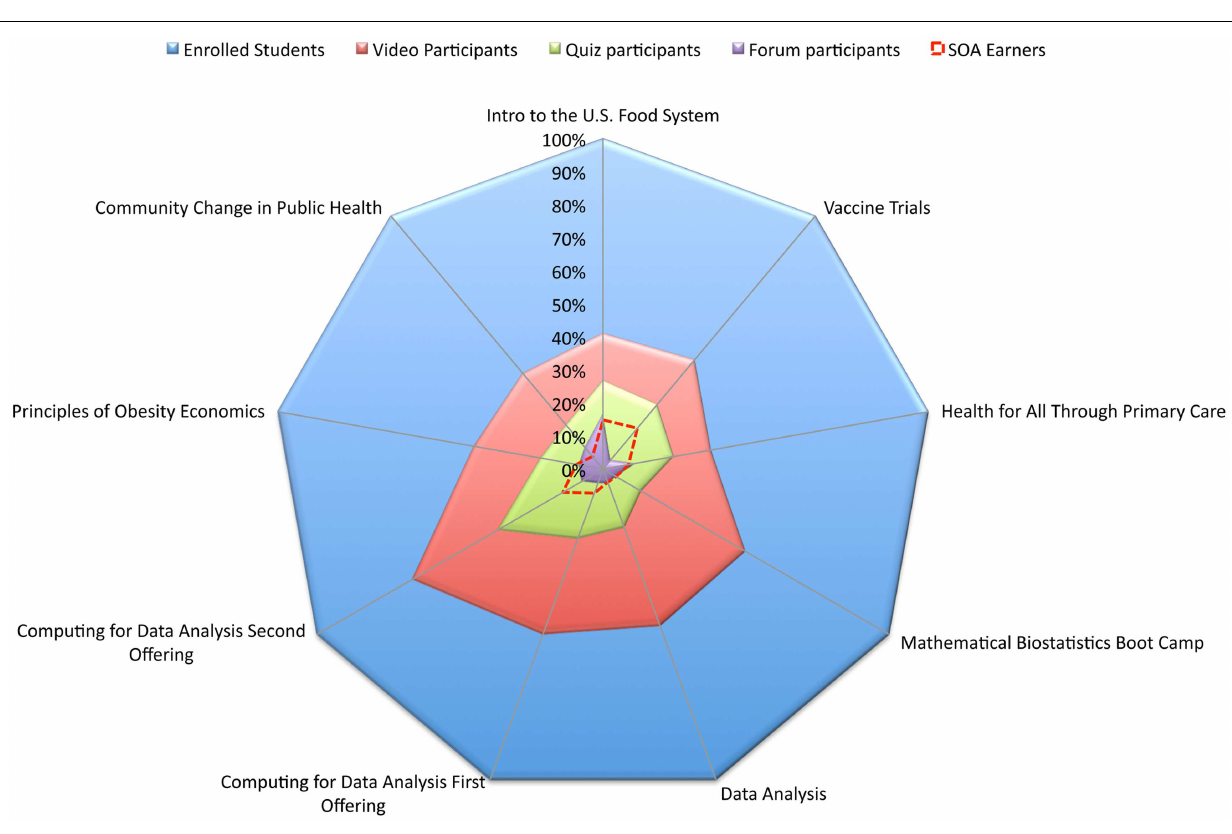
quantitative courses, but that is not the case; both types of courses sawabouthalf asmanyquizparticipantsasvideoparticipants.Par- ticipation in the quantitative courses dropped from 59.5% video participation to 29.2% quiz participation; whereas participation in the non-quantitative courses dropped from 37.8% in the 19.1%,